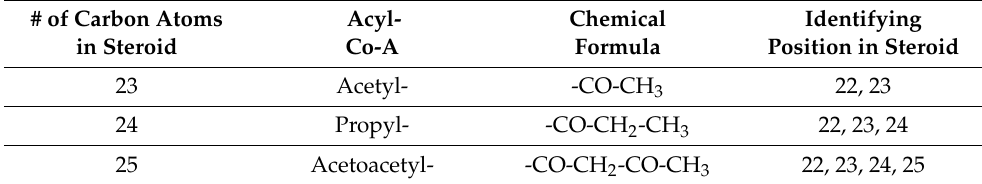
Table 3. Origin of the extra carbon atoms in spiral